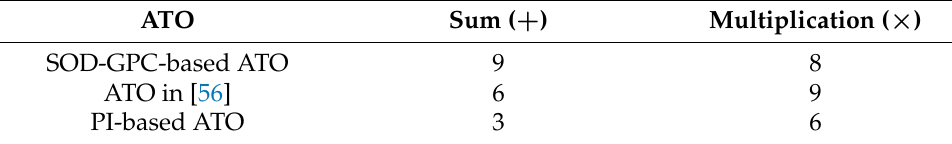
Table 2. Computational cost of ATOs.